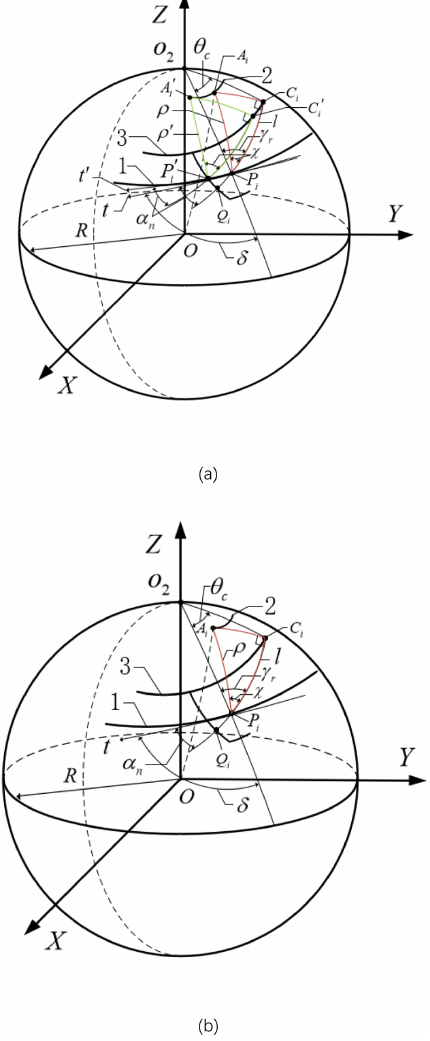
Figure 3. Relationship between pitch curve and base curves of tooth profile. (a) On the left side of the tooth profile. (b) The right side of the tooth profile. 1 – Pitch curve of circular bevel gear. 2 – Spherical base curve of pitch curve. 3 – Spherical base curve of tooth profile curve.